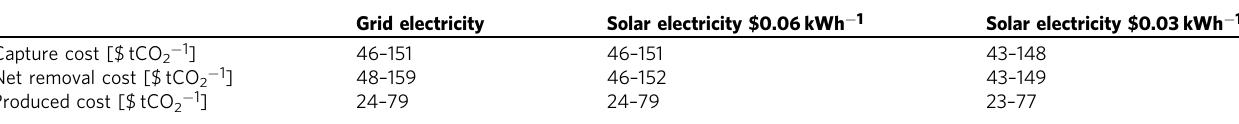
Table 5 Summary of CO 2 capture costs for the MgO looping process using costs as de fi ned in the section “ Calculating the cost of CO 2 ”